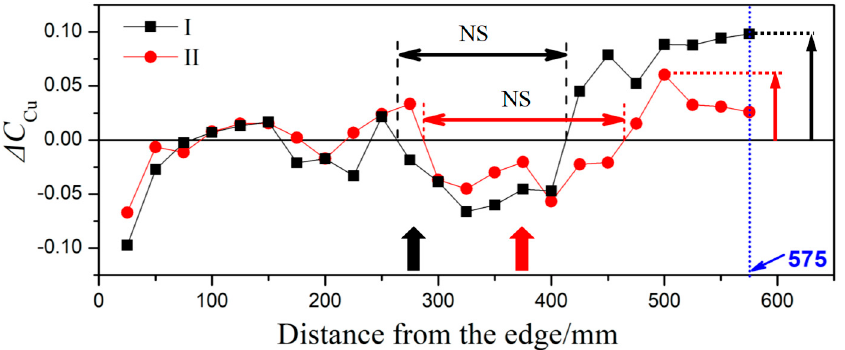
Figure 10. Segregation curves corresponding to the two groups of ultrasonic ingots with a diameter of Φ 1250 mm.